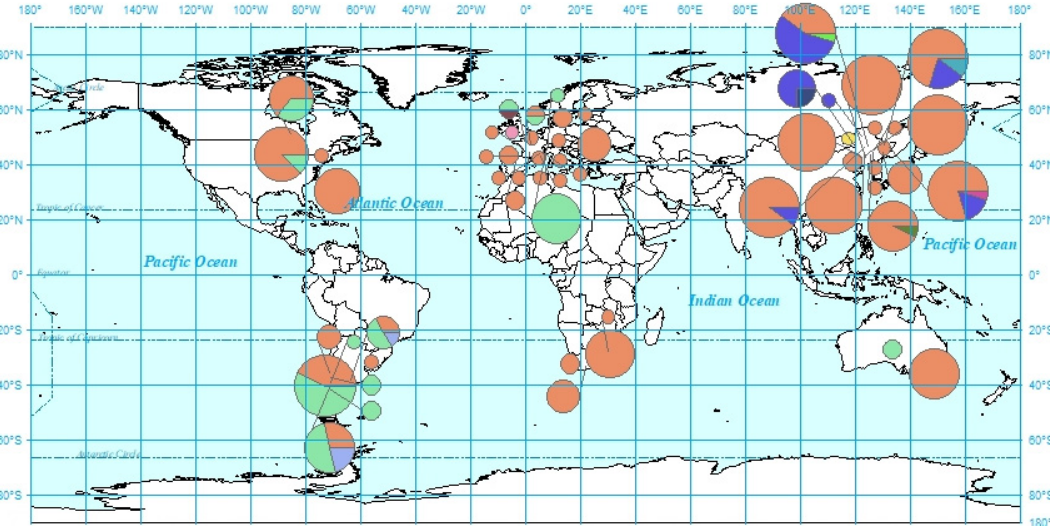
Figure 4. Global S. noctilio haplotype distribution. Colors correspond to the haplotype network shown in Figure 2.